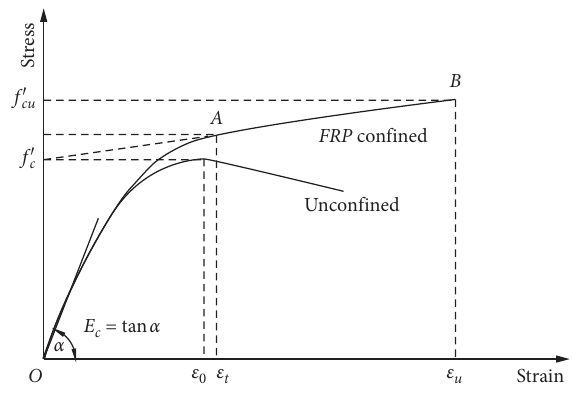
Figure 5: Stress-strain model of FRP-confined concrete proposed by Lam and Teng [25,